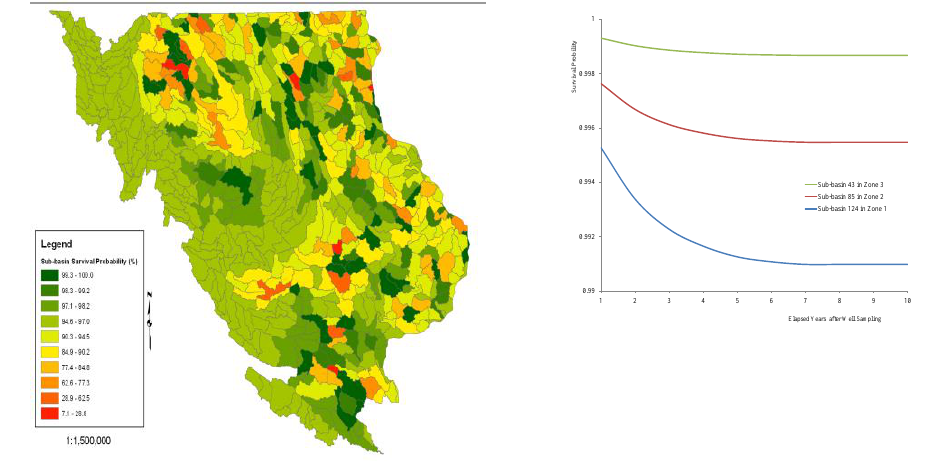
Figure 4. Map of groundwater failure and estimated subbasin probability of survival. The graph replicates the probability of survival for 3 wells, which depends on the number of years elapsed when a well is found to survive below the regulatory threshold (source: